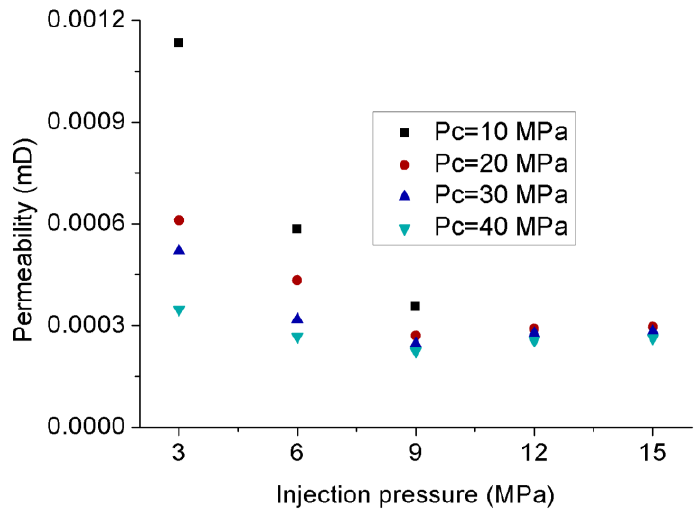
Figure 22. Relationship between permeability of siltstone at different injection pressures.